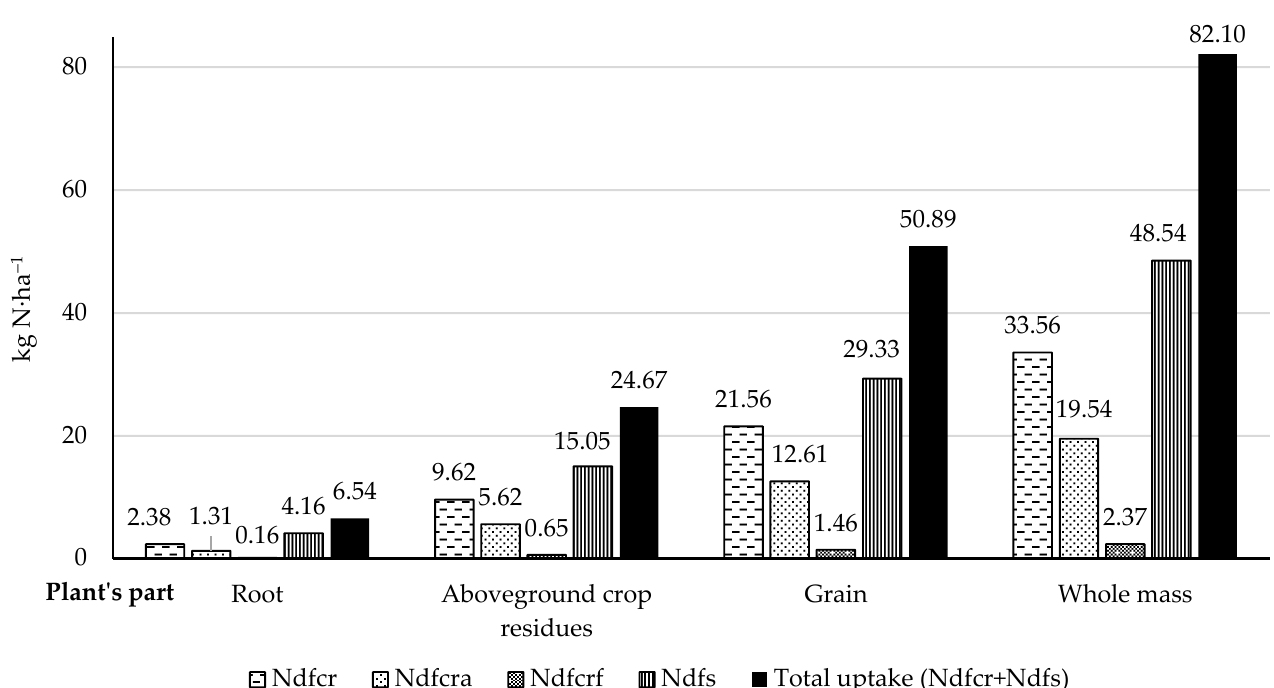
Figure 1. Nitrogen uptake from different sources by winter triticale succeeding pea (means for pea cultivars), kg N·ha − 1 . Ndfs, N derived from soil reserves; Ndfcr, N derived from peas or barley crop residues, respectively; Ndfcra, N derived from the atmosphere, introduced into soil with peas crop residues; Ndfcrf, N derived from fertilizer, introduced into soil with peas or barley crop residues. Table 6. Nitrogen uptake by winter triticale from different sources depending on the forecrop, kg N·ha − 1 (averages ± SD).